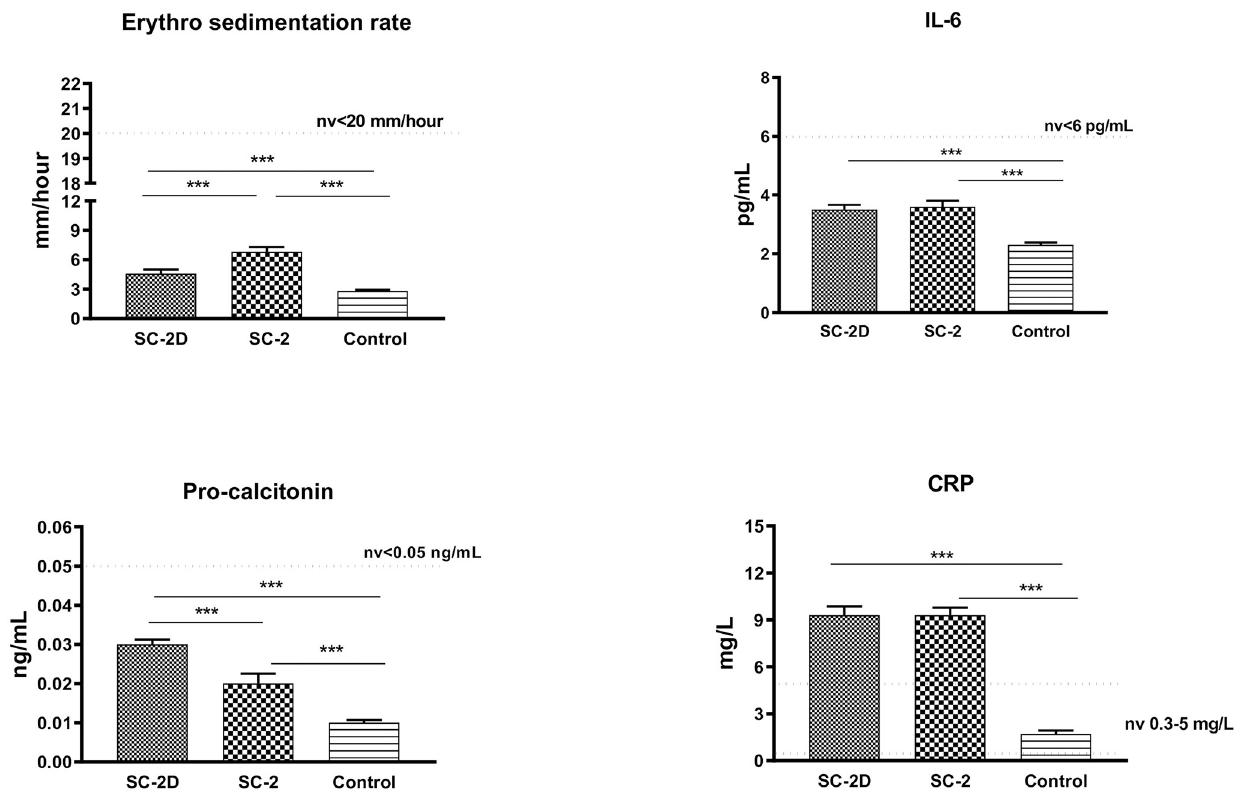
Fig 3. Inflammation biomarkers serum levels. Clinical biochemistry data on interleukin-6 (IL-6), C-reactive protein (CRP), erythrocyte sedimentation rate (ESR), and procalcitonin in Group 1: SC-2D, Group 2: SC-2, and Group 3: Control. Results are shown as mean ± SD. The analysis of variance test was performed to evaluate the differences between groups. ��� P < 0.01. P values remained significant after Bonferroni comparisons (P < 0.01).